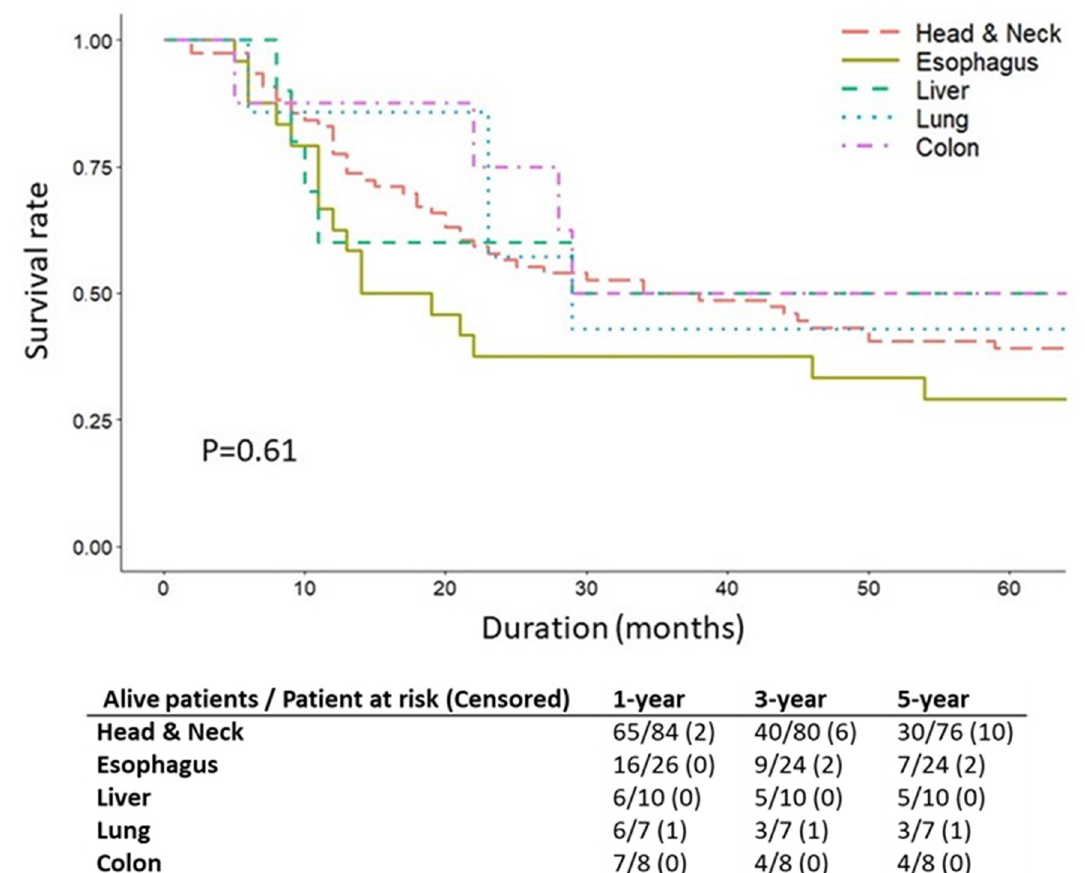
Fig 3. Kaplan-Meier survival curves for different second primary malignancy (SPM) sites in 157 SPM patients.